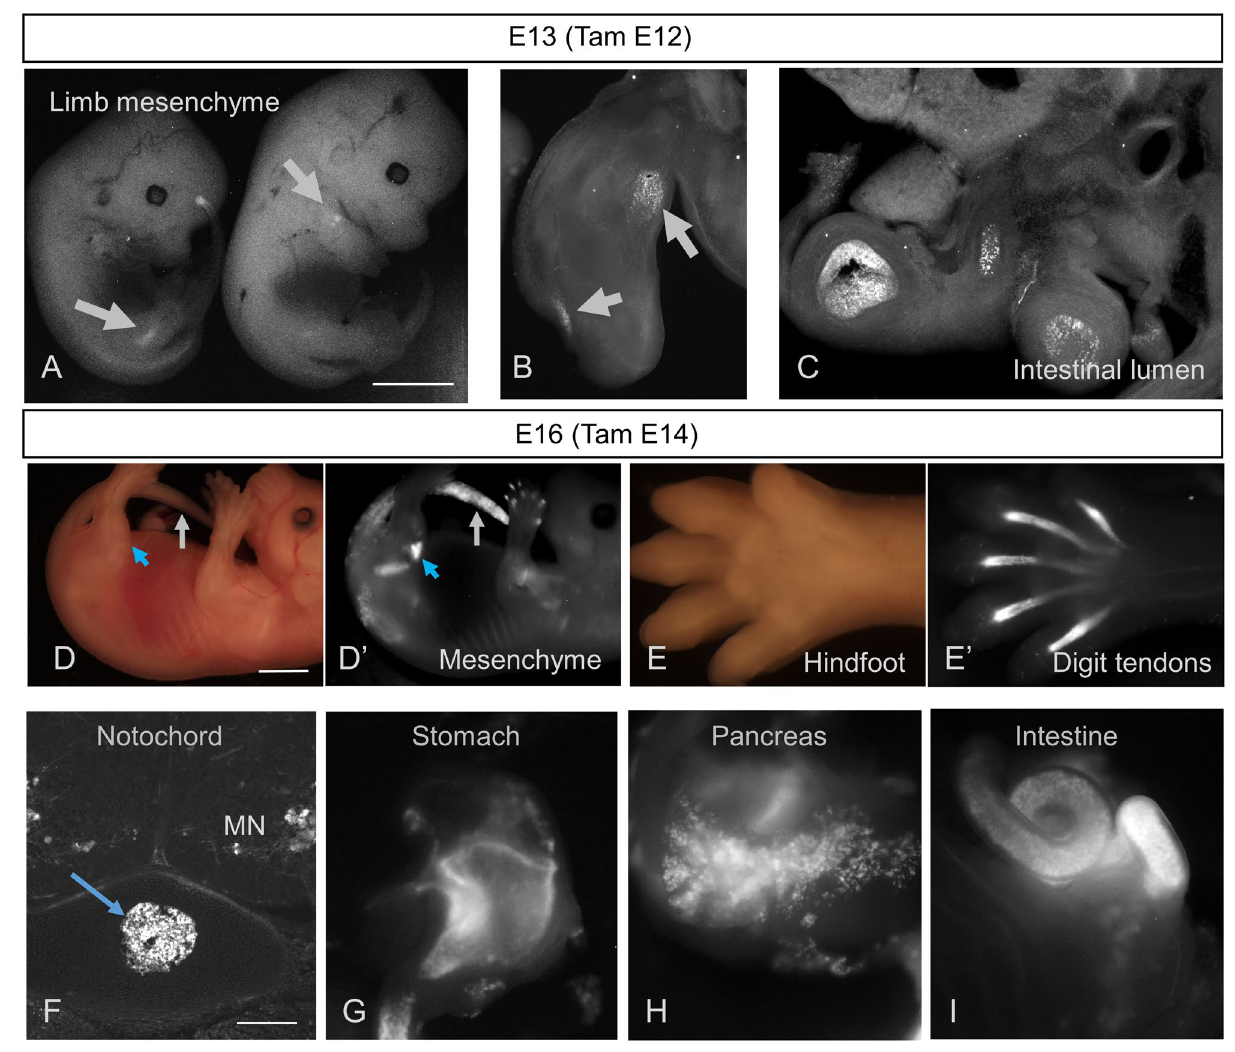
Figure 2. Sites of pre-natal Hb9-CreER recombination outside of the CNS. ( A – C ) ROSA-lox-stop-lox-EYFP reporter expression in mid-gestation HB9-CreER mice following IP administration of tamoxifen to pregnant dam at E12, revealing recombination outside of the CNS evident in limbs of E13 animals ( A ), vibratome sections of forelimb ( B ), and the lumen of the intestine ( C ). ( D , E ) Brightfield ( D , E ) versus Ai14 tdTomato reporter expression ( D ′ , E ′ ) in E16 mice induced with tamoxifen at E14, showing recombination in limb and tailbud mesenchyme ( D ′ ) and tendons of the knee ( D ′ , blue arrow) and Hindfoot ( E ′ ). ( F – I ) Additional sites of Ai14 tdTomato reporter expression after E14 tamoxifen induction, including known sites of non-neuronal Hb9 expression such as notochord ( F ), stomach ( G ), pancreas ( H ), and intestine ( I ). Scale bars: ( A ) and ( D ), 2 mm; ( F ) 250